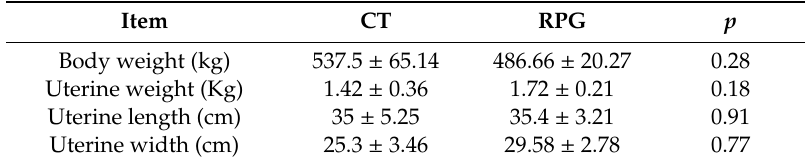
Table 4. Effects of rumen-protected glucose (RPG) on the weights of body and uterus in post-natal dairy cows.